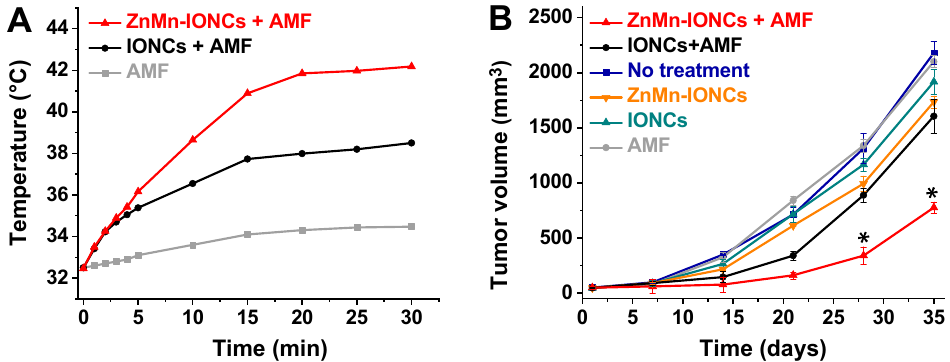
Figure 8. ( A ) Intratumoral temperature curves during AMF (420 kHz, 26.9 kA / m) exposure of animals treated with 5% dextrose (AMF), ZnMn-IONCs (10 mg of Fe / kg) and IONCs (10 mg of Fe / kg). ( B ) Tumor growth profiles after four cycles of the following treatments: (i) no treatment; (ii) ZnMn-IONCs + AMF, mice injected with ZnMn-IONCs (10 g of Fe / kg) and subjected to AMF for 30 min; (iii) IONCs + AMF, mice injected with IONCs (10 g of Fe / kg) and subjected to AMF for 30 min; (iv) ZnMn-IONCs, mice injected with ZnMn-IONCs (10 g of Fe / kg); (v) IONCs, mice injected with IONCs (10 g of Fe / kg); and (vi) AMF, mice injected with 5% dextrose and exposed to AMF. * p < 0.05 when compared with non-treated animals.